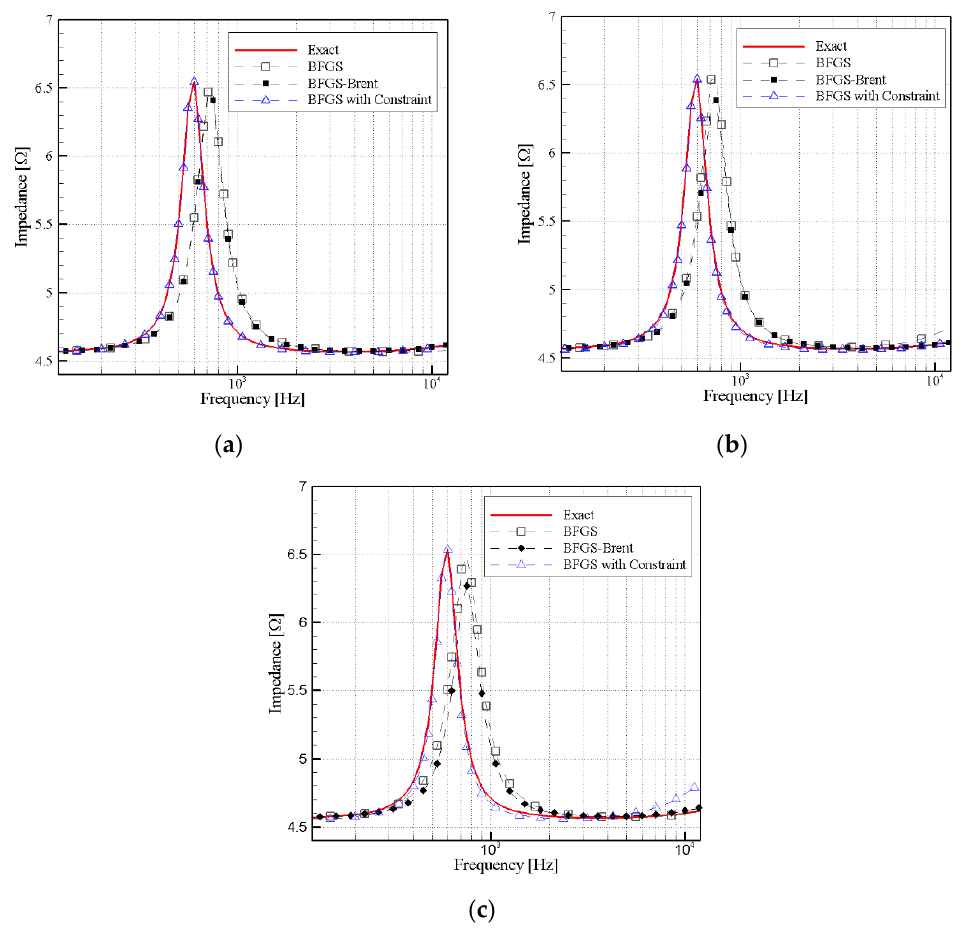
Figure 8. Comparison of impedance curves at different measurement errors ( σ = 0.01,0.05,0.15 ) ,